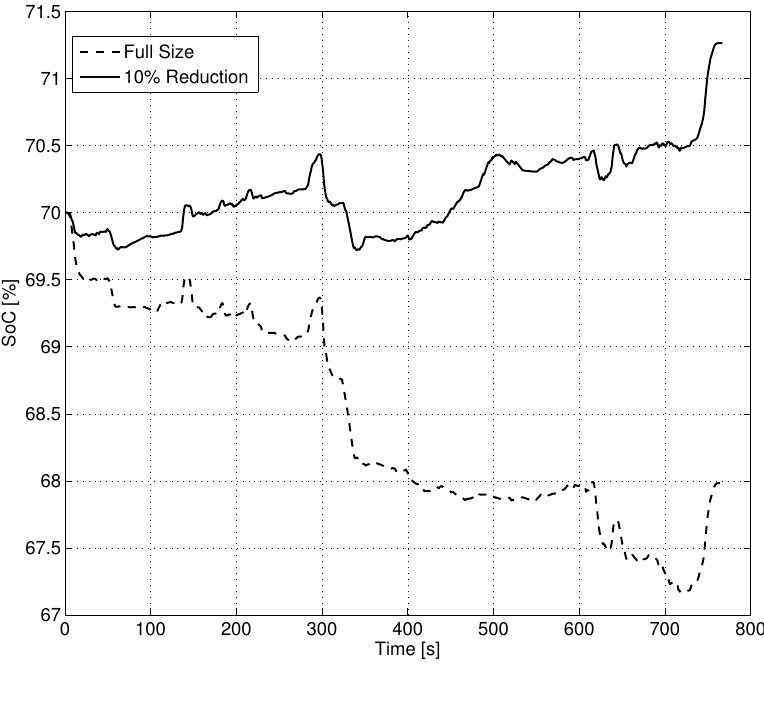
Figure 13. State of charge comparison for the